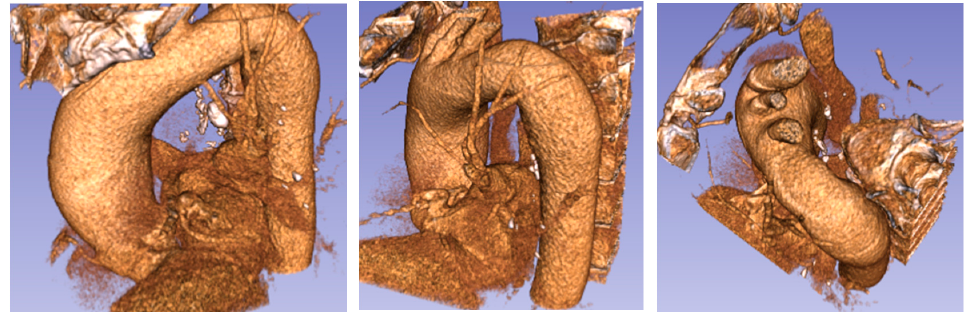
Figure 4. Patient 2 (76 years old) with an ascending aorta aneurysm.